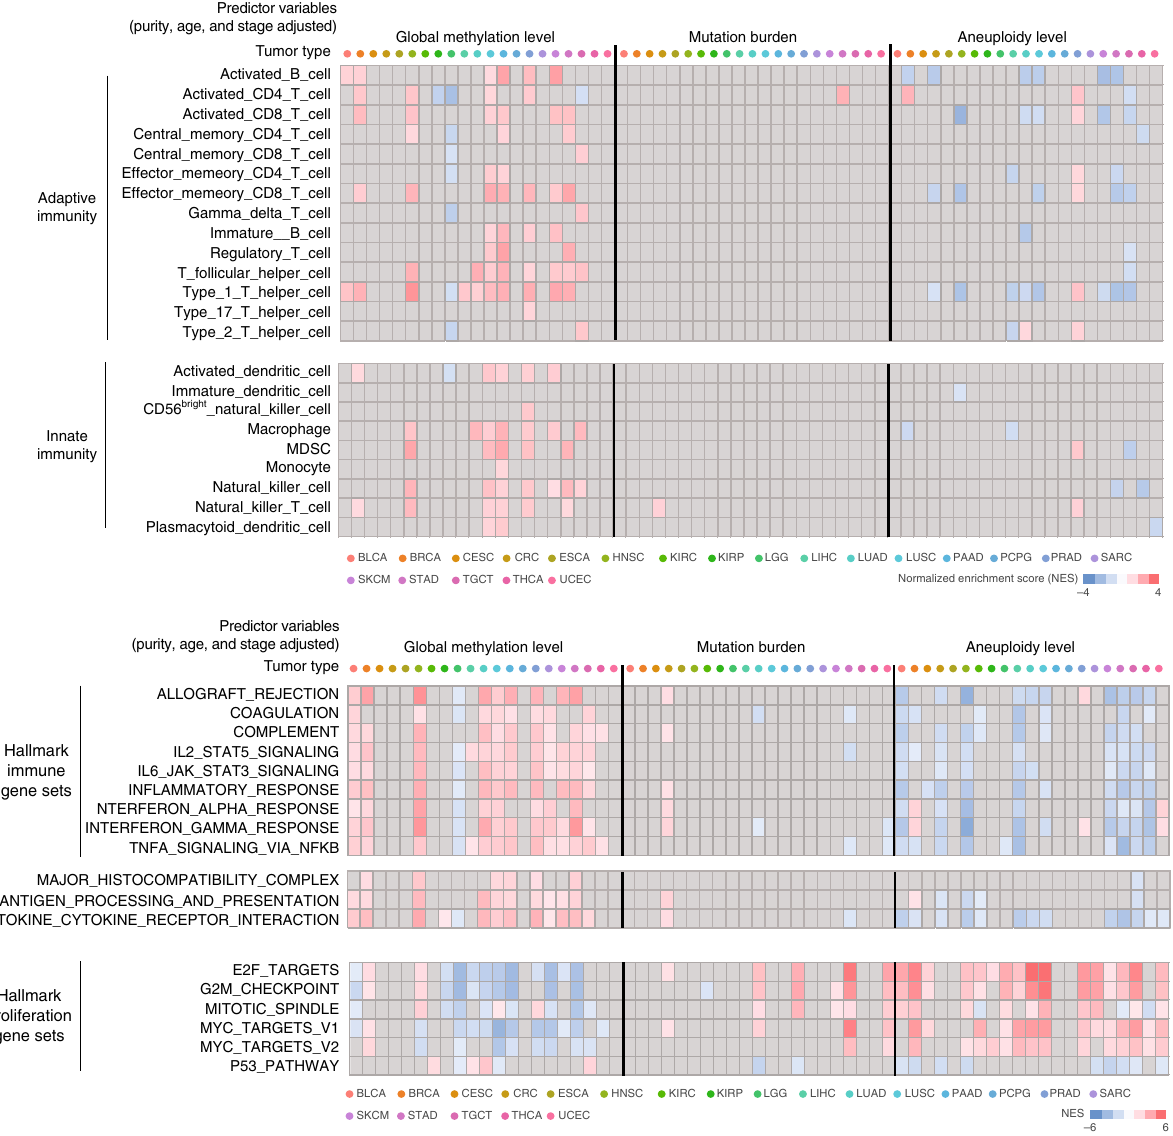
Fig. 2 Genomic methylation loss correlates with immune evasion signatures. a Heatmap of Gene Set Enrichment Analysis (GSEA) 48 normalized enrichment scores (NESs) for gene sets representing various types of innate and adaptive immune cells (rows). For each gene per cancer type, a linear regression model was fi t using mRNA expression level as response variable and global methylation, mutation burden, aneuploidy, tumour purity, age, and tumour stage as predictors. For each of three predictors (global methylation level, mutation burden, aneuploidy level), GSEA was performed on genes with signi fi cant regression coef fi cients. Cells with signi fi cant NES (FDR <0.25) are colour-scaled. b Heatmap of GSEA NESs for hallmark immune and proliferation gene sets and genes involved in antigen processing and presentation, MHC, or cytokine-cytokine receptor expression levels of ERVs and L1s from the tumour samples. The correlation of their expression levels with the indicators of cytotoxic immune activity was not positive but negative in general (Supplementary Fig. 5), implying that IFN- α / β silencing overrides the immune-stimulatory effects of ERV/L1 expression by genomic demethylation.